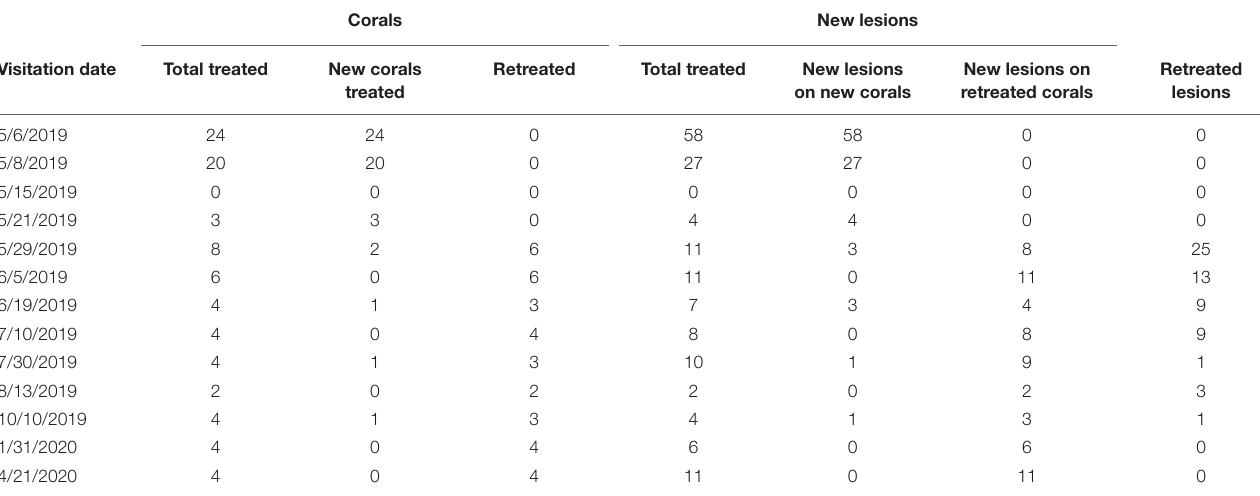
FIGURE 3 | The proportion of treatments ( n = 34 per panel) succeeding at halting the disease following antibiotic (A) disease margin and (B) disease-break treatments, and chlorinated epoxy (C) disease margin and (D) disease-break treatments over time. The high initial disease-break successes were from the disease lesions not yet reaching the treatment. TABLE 3 | Summary of lesion and coral treatments by visitation